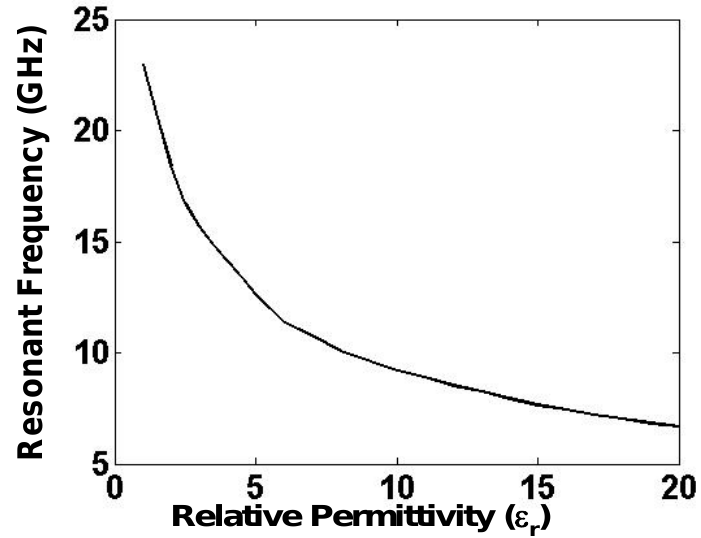
Figure 6. The characteristic curve of the detector showing the variation of the resonant frequency with the dielectric